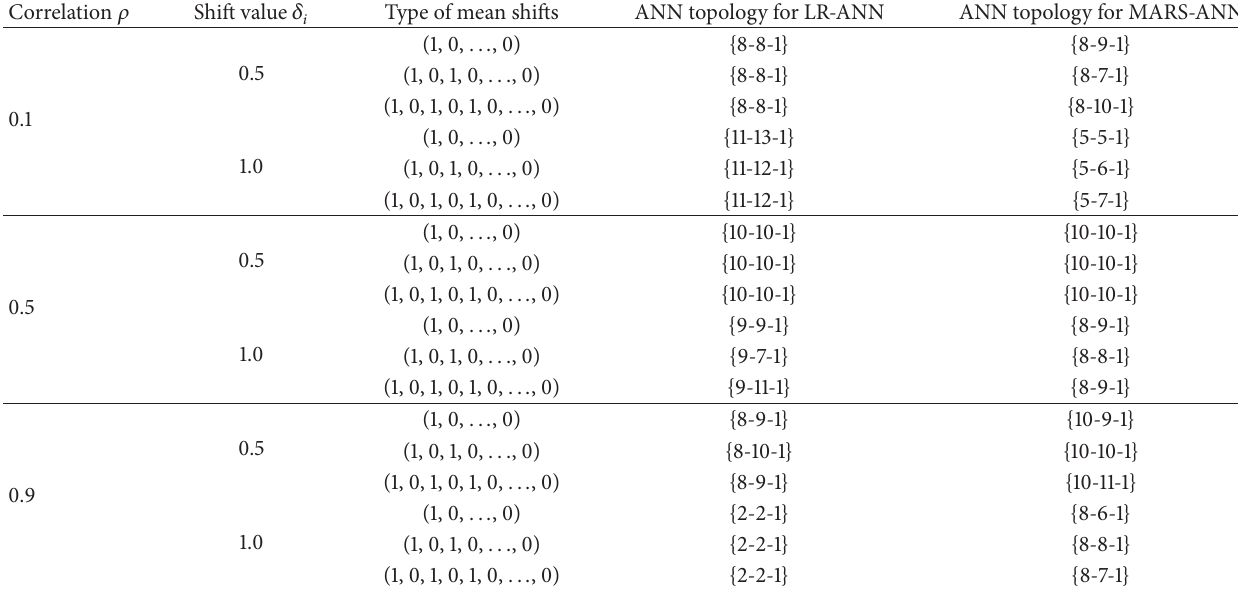
Table 9: ANN topology settings for different hybrid LR-ANN and MARS-ANN